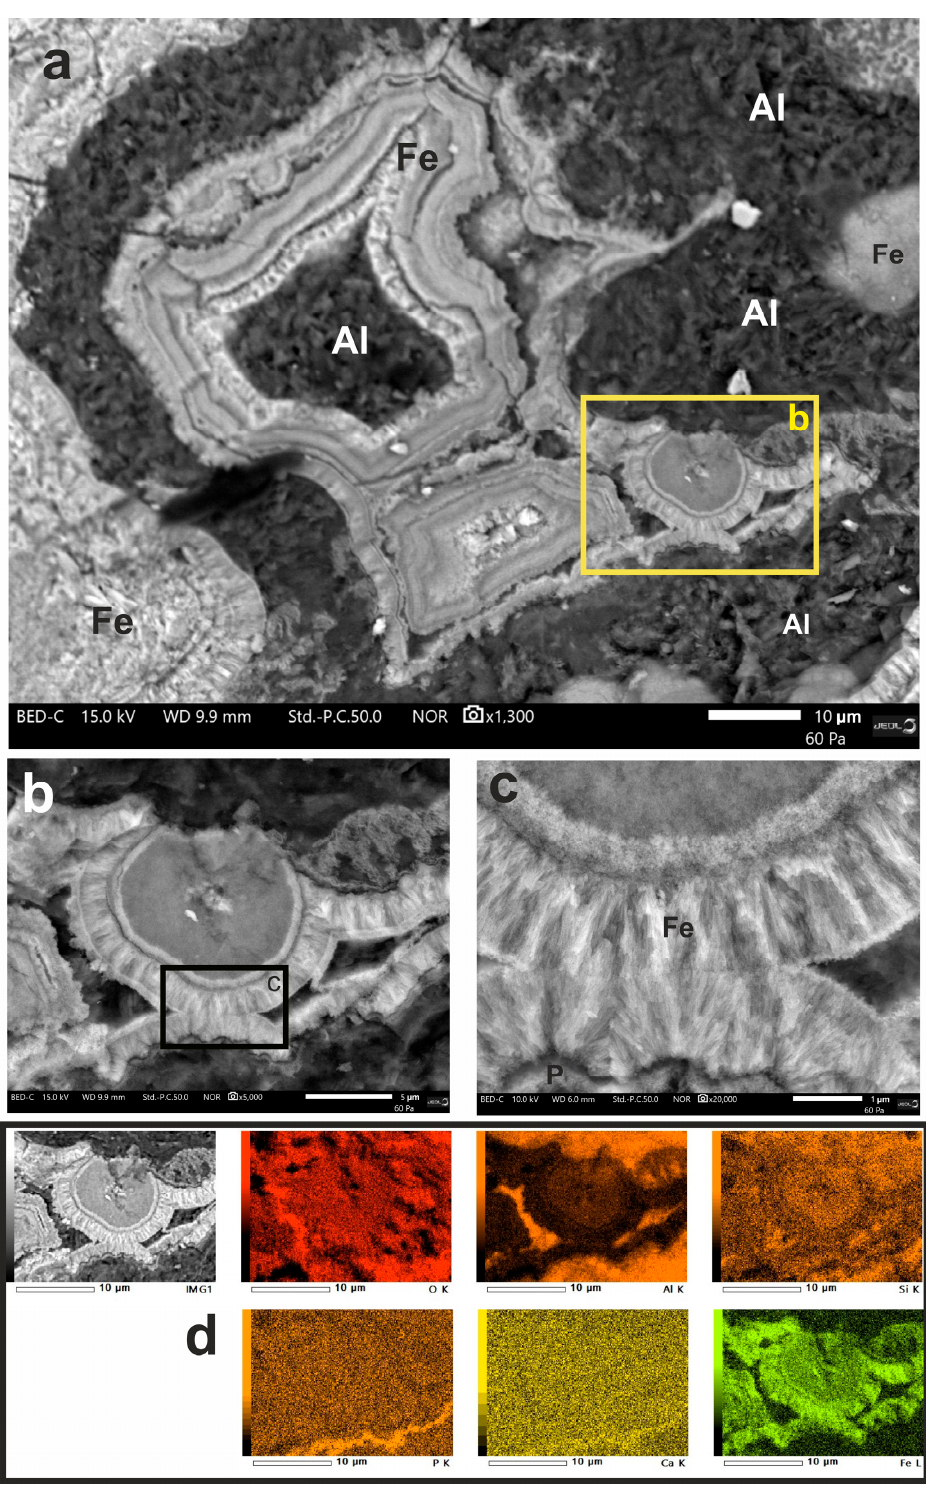
Figure 3. SEM-EDX micrographs of pisoliths with a massive structure of goethite: ( a ) colloform rhythmites in goethite; ( b ) close-up view of the mammillary-shape ferriallophane; ( c ) with feathery fan-shaped arrangements of goethite (goethite palisades); ( d ) elemental mapping of the “b” surface area. Fe—iron oxides; Al—clay minerals; P—phosphates.